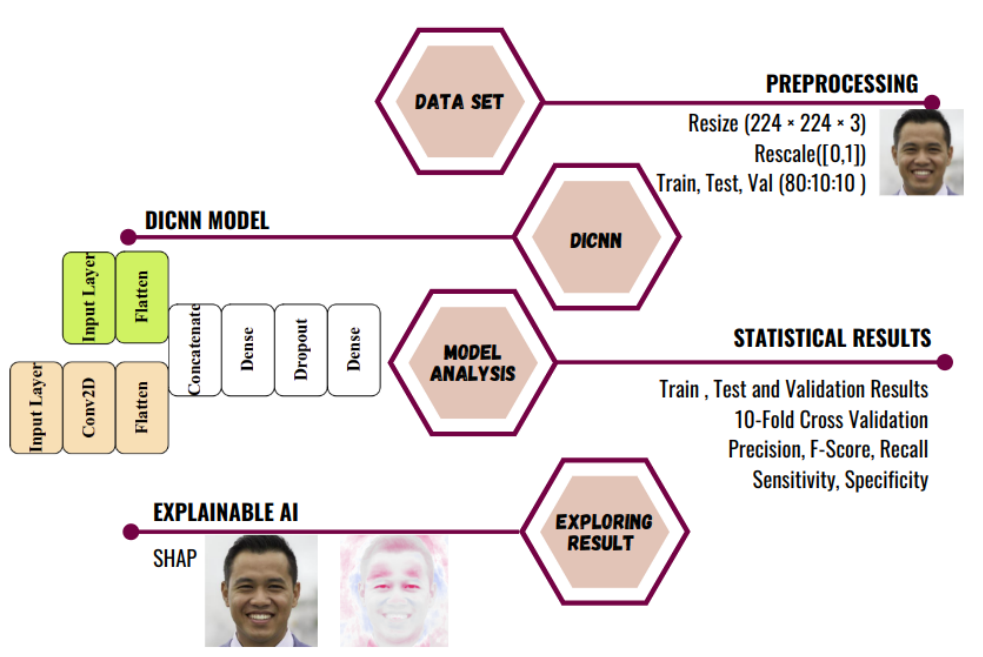
Figure 2. The proposed model to augur doctored images into fake and